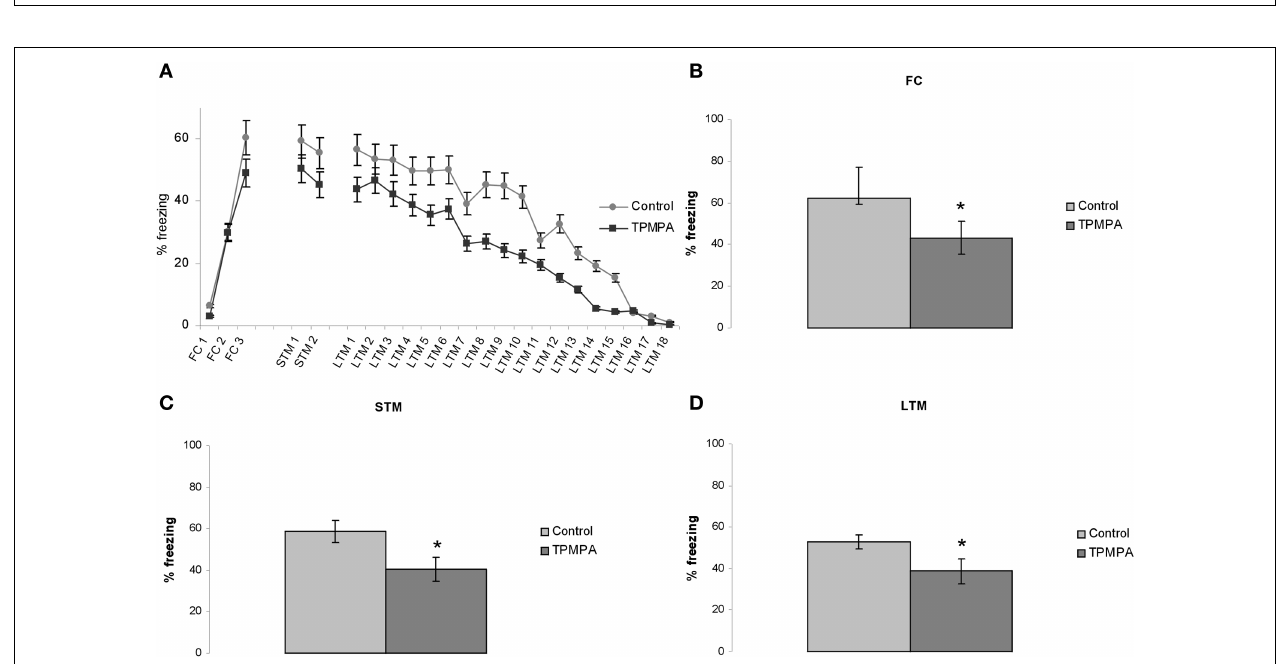
Diagrams show a signifi cant difference between the control (vehicle injection) and muscimol groups for FC, fear conditioning; STM, short-term memory test; and LTM, long-term memory test ( p < 0.05).